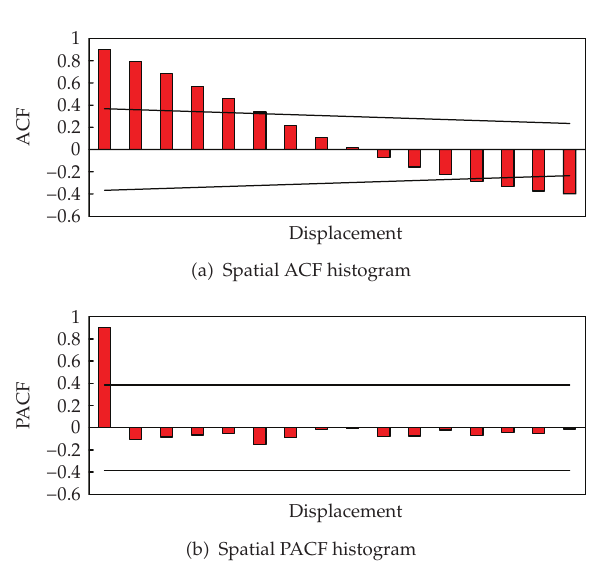
Figure 4: Histograms of spatial ACF and PACF of Hangzhou’s population density (cid:6) 2000 (cid:7) . The two lines in the histograms are called “two standard-error bands,” according to which we can know whether or not there is significant di ff erence between ACF or PACF values and